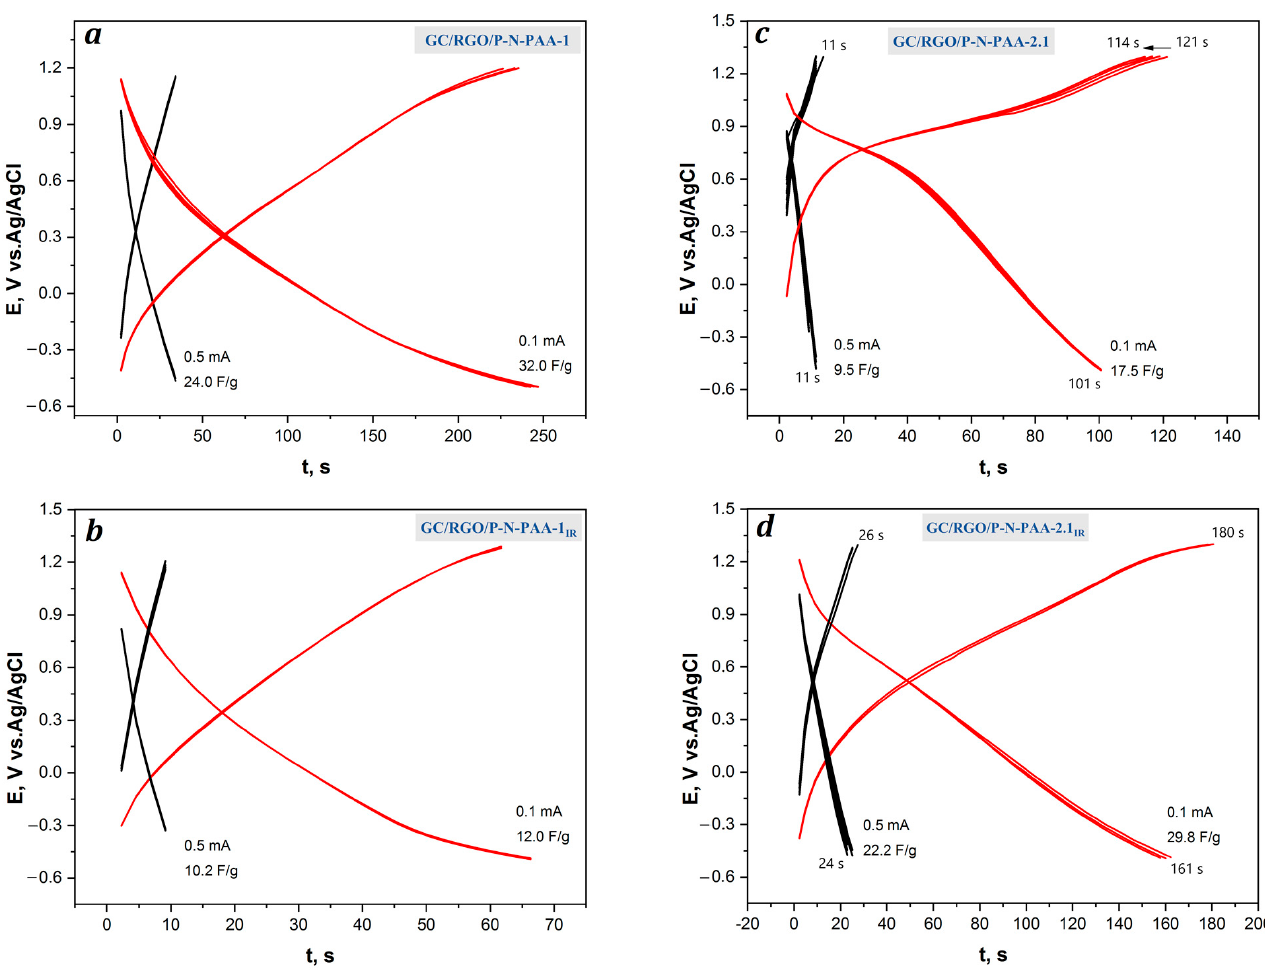
Figure 10. Galvanostatic charge–discharge dependencies of the GC/RGO/P-N-PAA electrodes ( a – d ) at 0.1 and 0.5 mA·cm –2 .